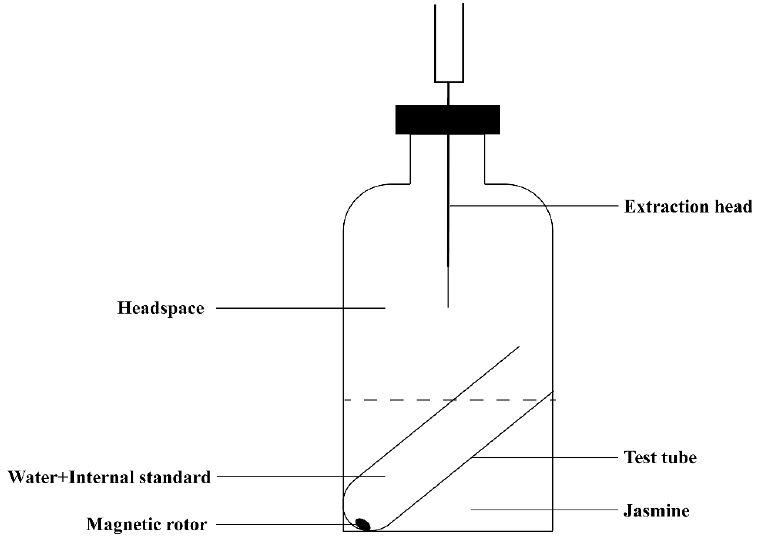
Figure 10. Diagram of aroma extraction